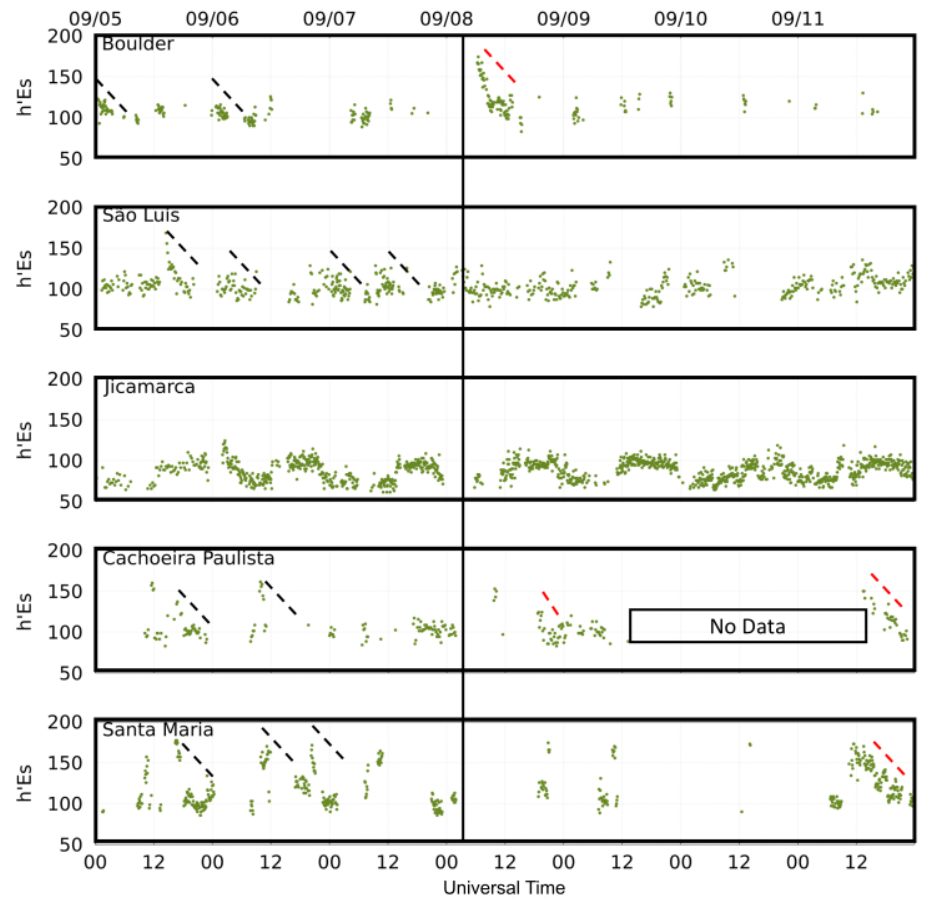
Figure 4. The h’ Es parameter (green symbols) from top to bottom: Boulder, São Luís, Jicamarca, Cachoeira Paulista, and Santa Maria on 5–11 September 2017. The dashed lines refer to the downward movement of the Es layer at low and middle latitudes, and the black and red lines are related to the days before, during, and after the magnetic storm occurrence, respectively.